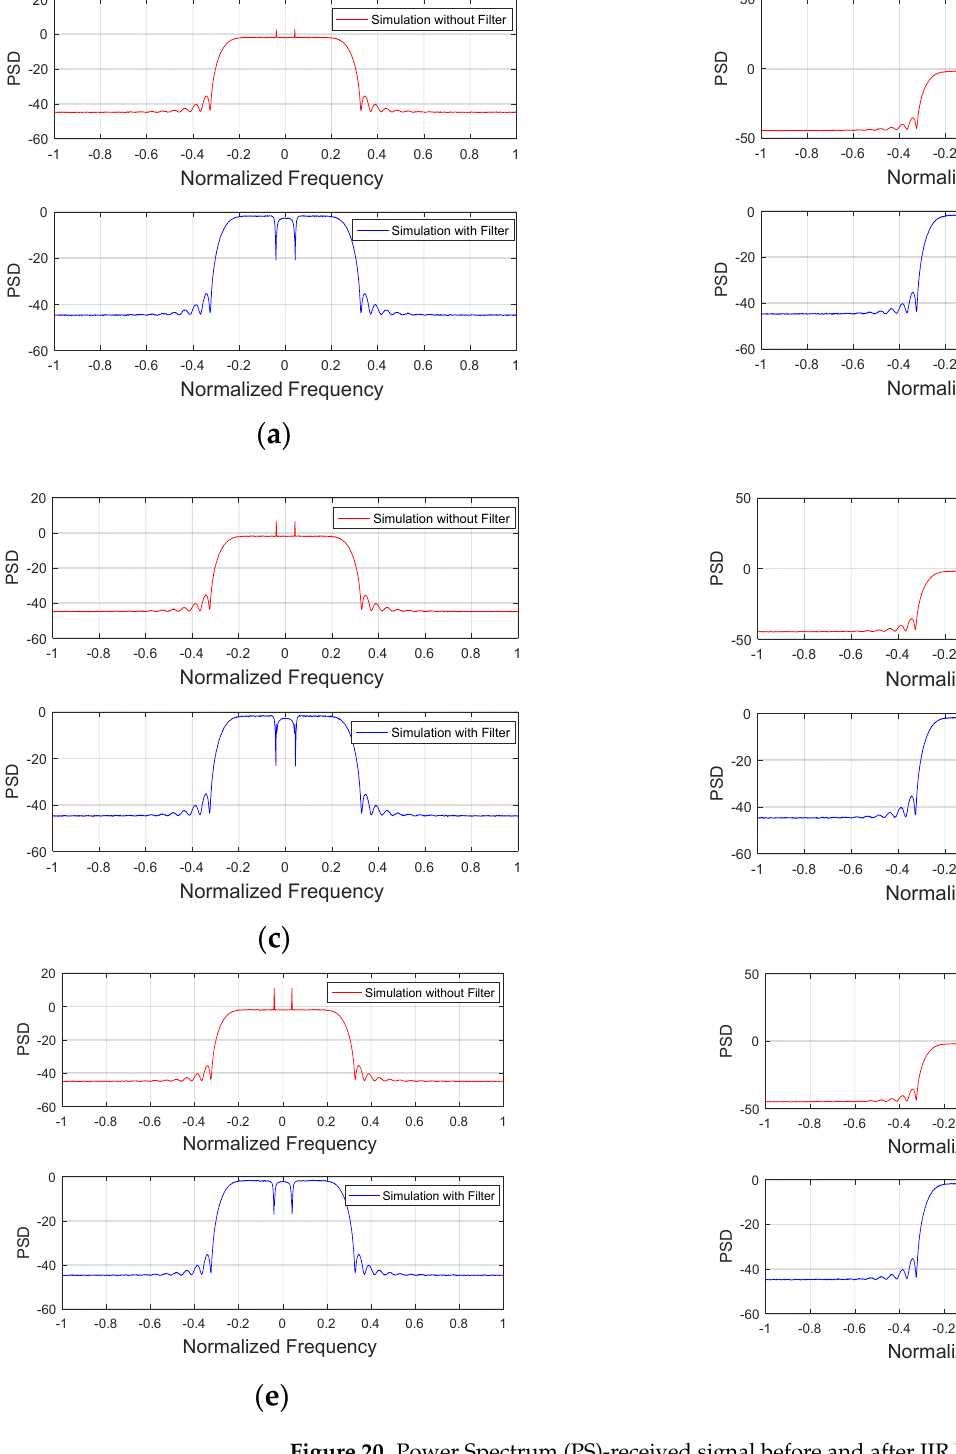
Figure 20. Power Spectrum (PS)-received signal before and after IIR NF processing: ( a ) JSR = − 20 dB,